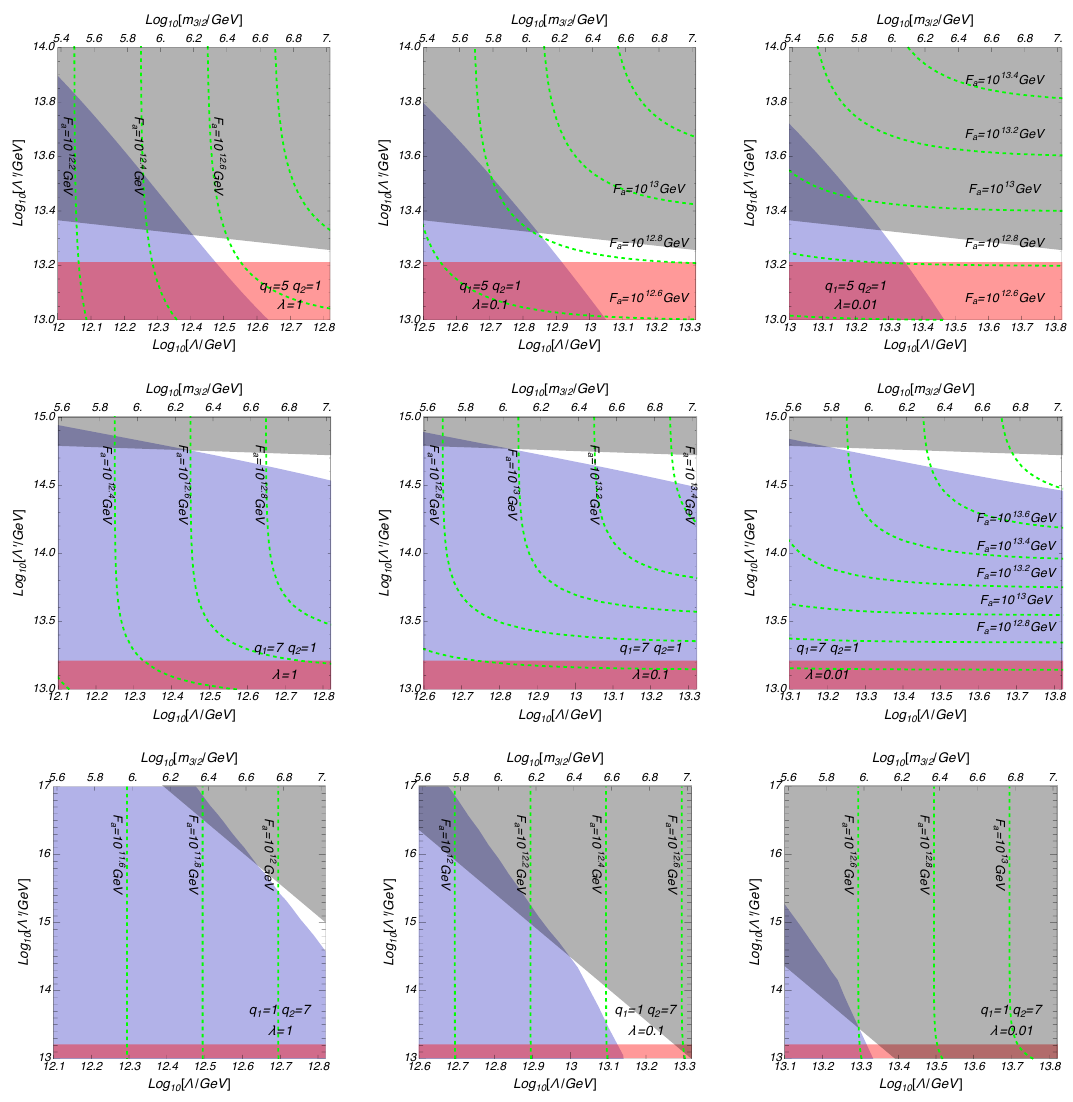
Figure 2 . The constraints on the parameter reions for given PQ charges, q 1 and q 2 . The gray region is excluded as (cid:18) e(cid:11) < 10 (cid:0) 10 is not satis(cid:12)ed. The perturbative uni(cid:12)cation is not achieved & 750 GeV. The green lines are the in the blue region. The red regions are excluded by m 0 KSVZ contours of the e(cid:11)ective decay constant F a